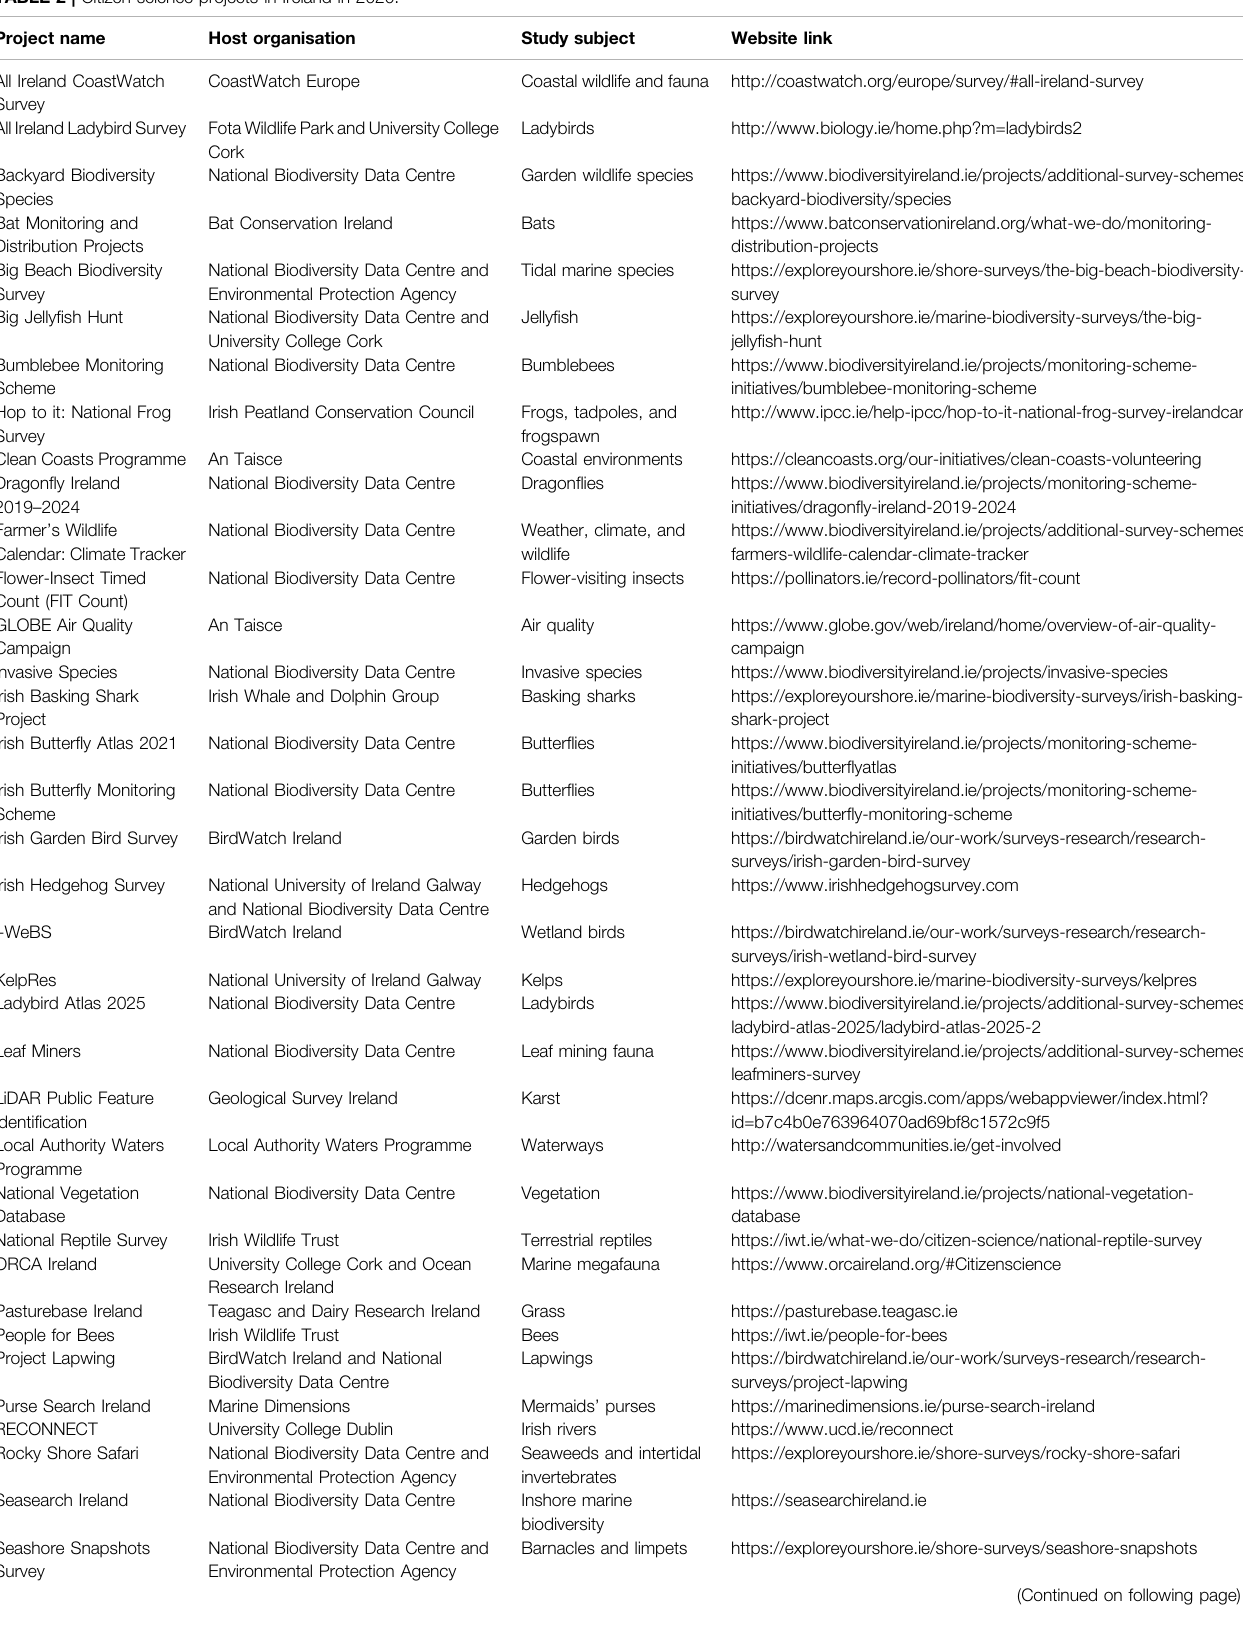
TABLE 2 | Citizen science projects in Ireland in